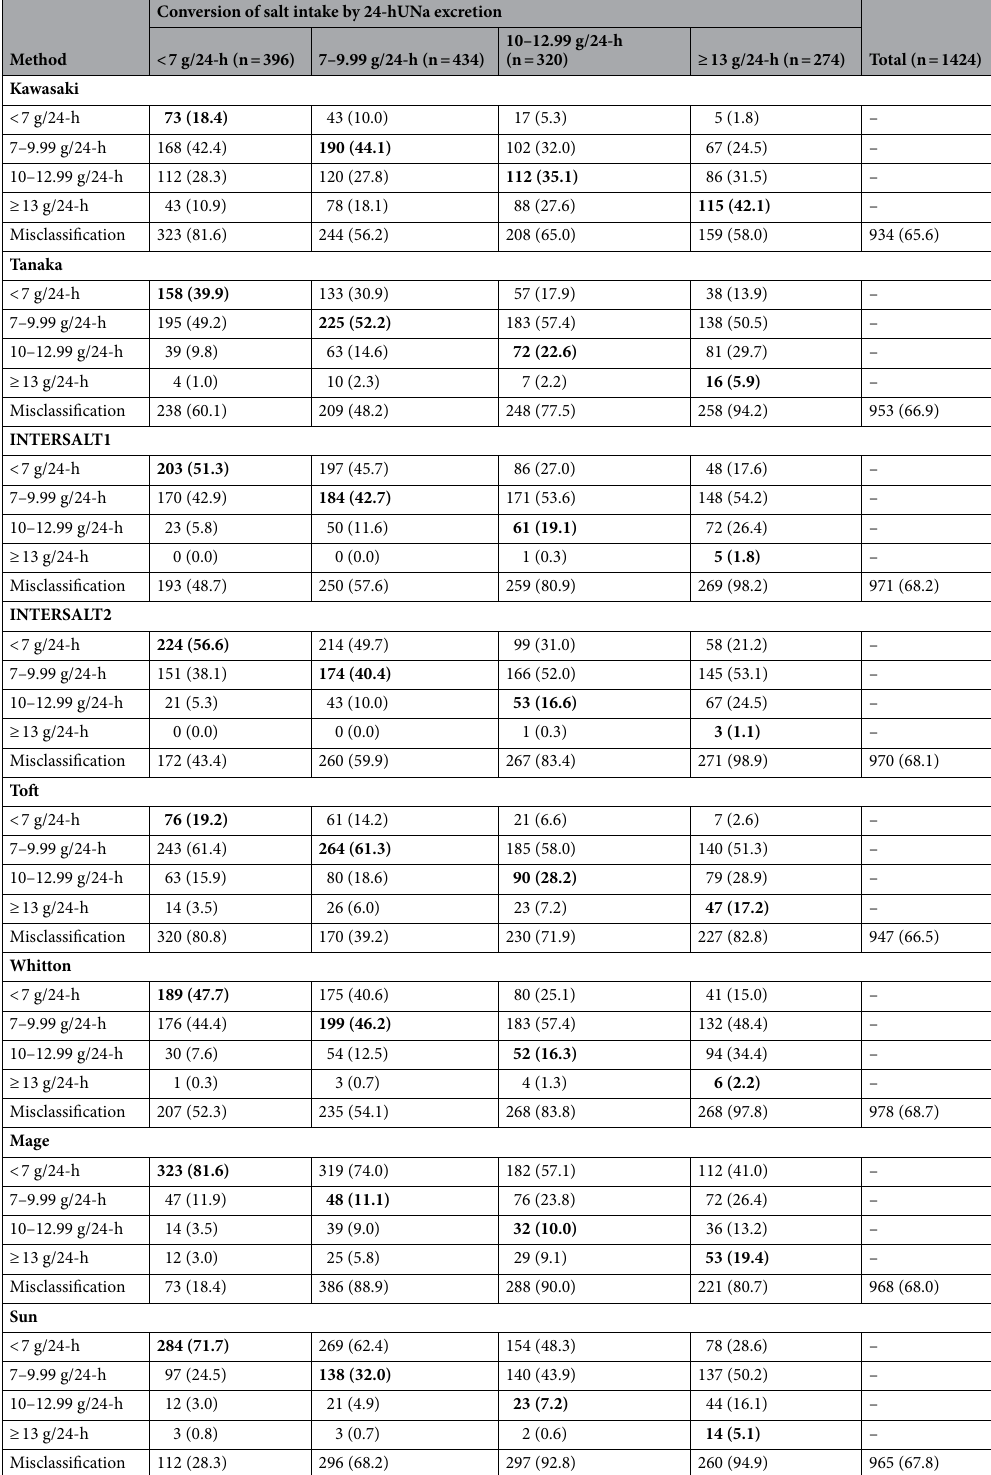
Table 4. Misclassification of the eight predicted methods for individual salt intake level, n (%). The numbers in bold in the table indicate the number and percentage of cases where the estimated value is consistent with the measured 24-hUNa excretion